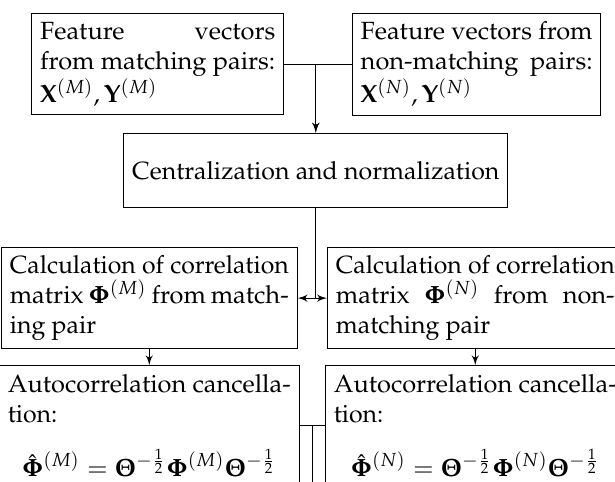
Figure 1. Modified VGG16 for feature extraction.